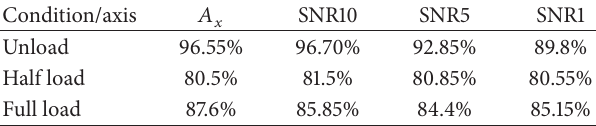
Table 2: Classification percentage for each condition using 𝑘 NN.